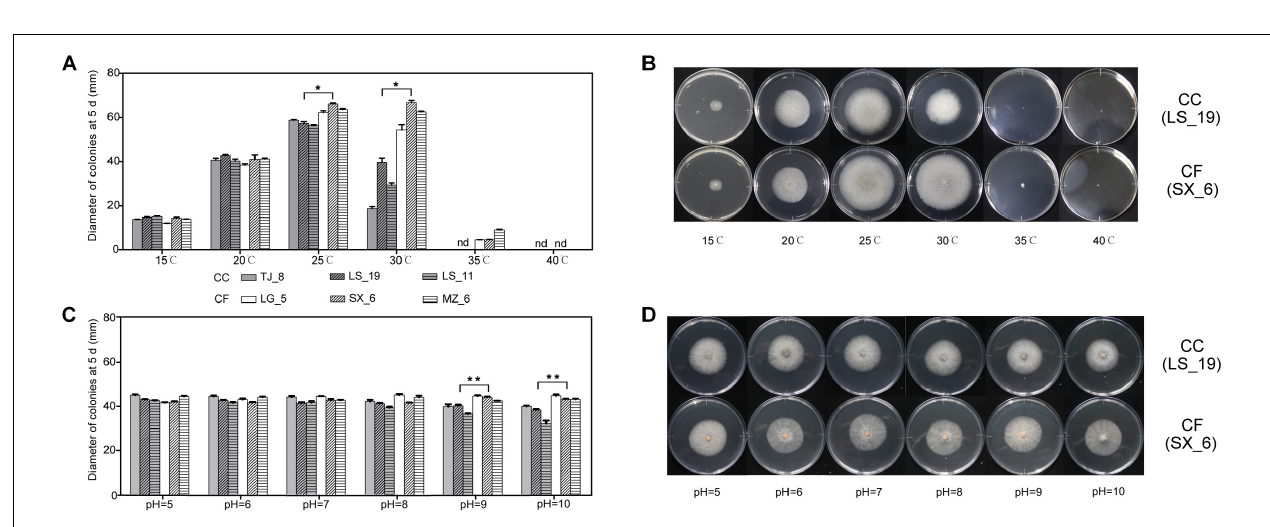
FIGURE 4 | Effect of environmental factors on the growth of C. camelliae and C. fructicola . (A,B) Effect of temperature. (C,D) Effect of pH. ∗ P < 0.05 and ∗∗ P < 0.01 by the LSD test (comparing LS_19 and SX_6); nd, not detectable. The error bars represent SEM; n = 3.